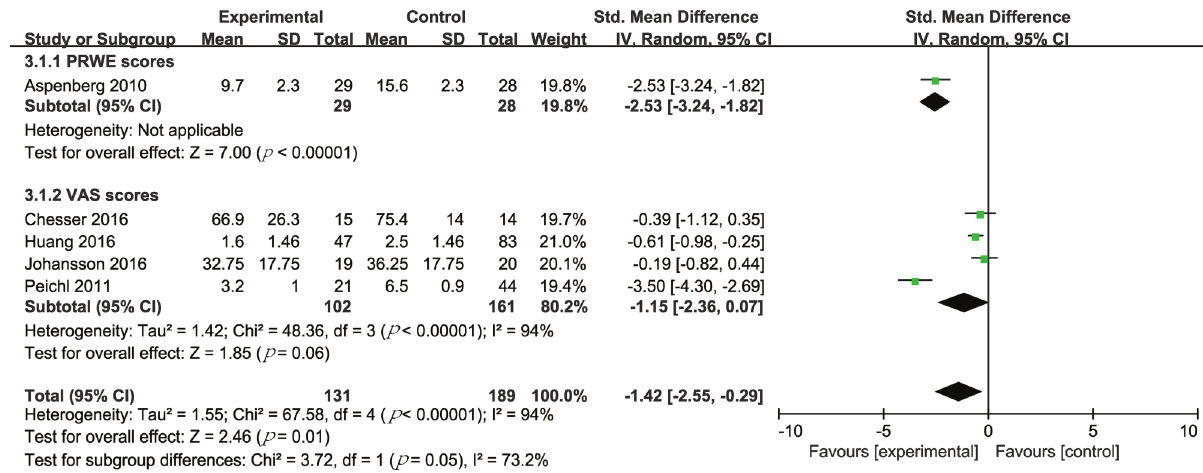
Figure 5 - Forest plot for degree of fracture pain.